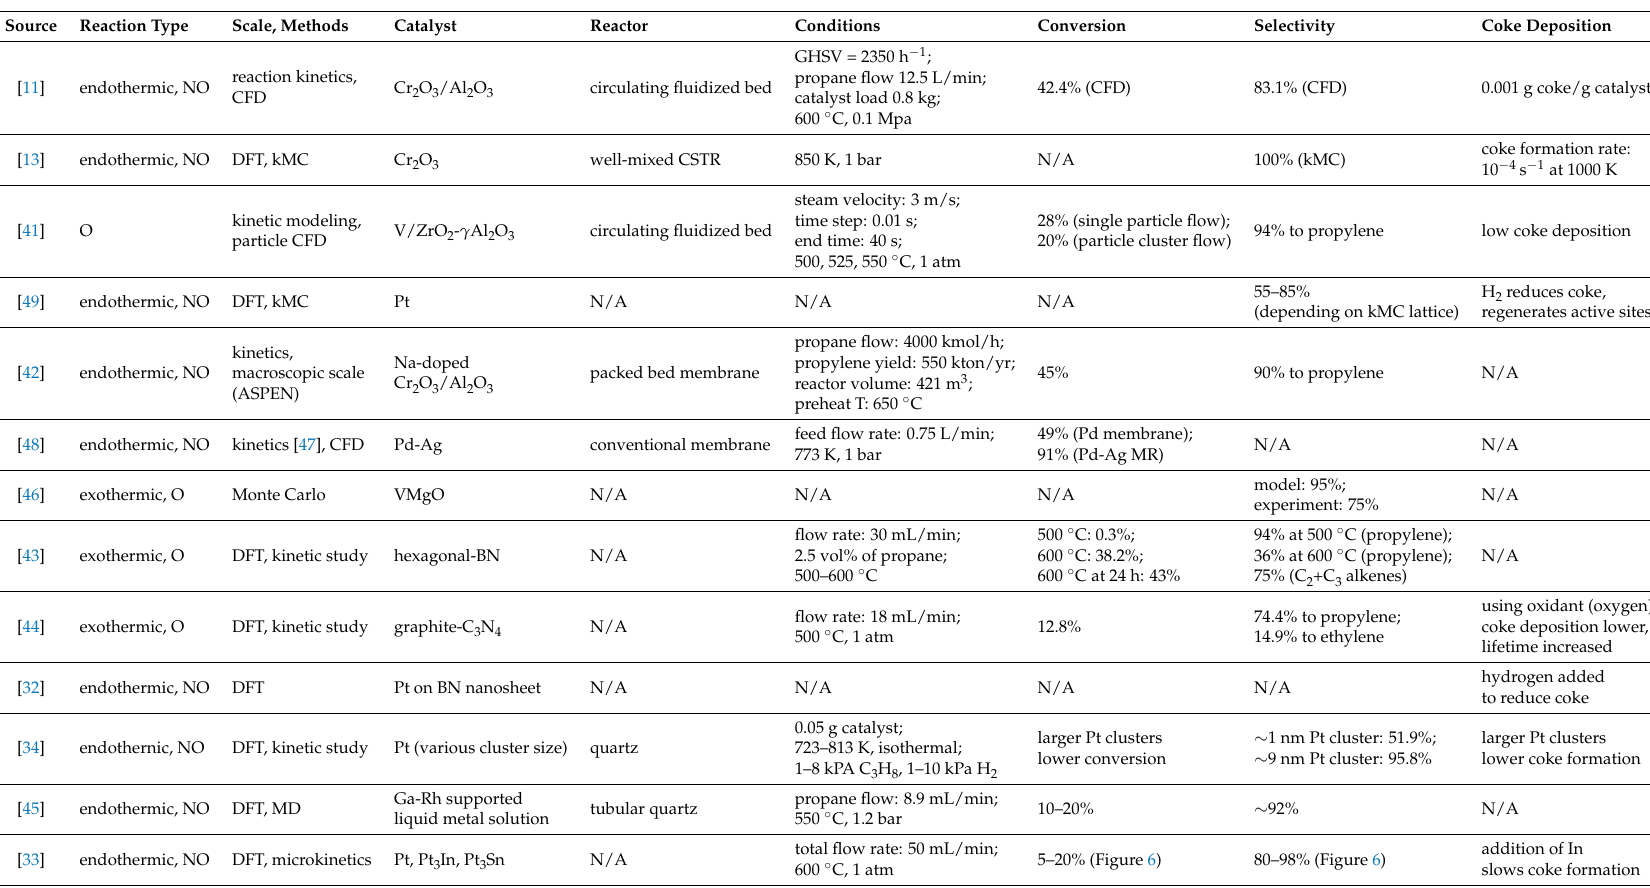
Table 2. The overview of the multiscale modeling results for propane dehydrogenation process over different catalysts, reactor types, and conditions. Oxidative (O) and non-oxidative (NO) reaction types were